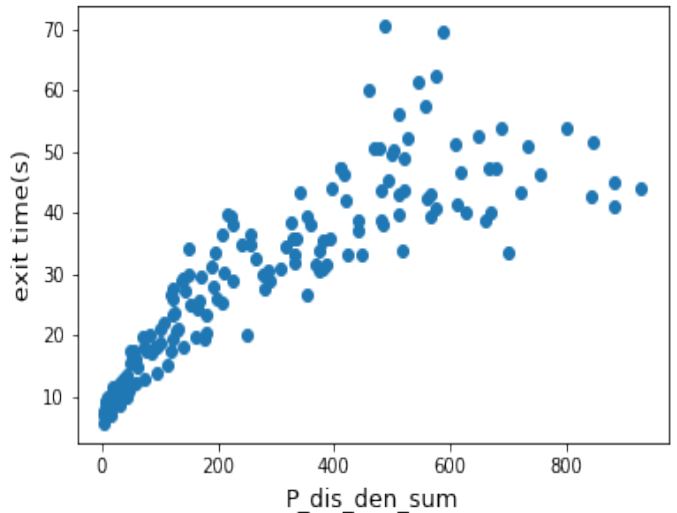
Figure 7. The scatter diagram of evacuation time with the total people distribution